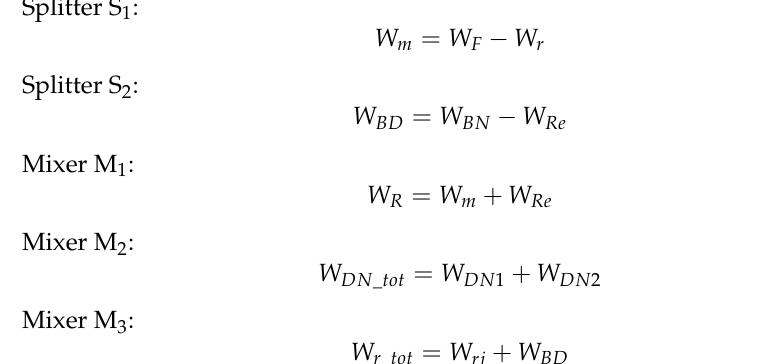
Figure 2. Option 2 — the BR-MSF system and SWRO system with independent feed water. Figure 2. Option 2—the BR-MSF system and SWRO system with independent feed